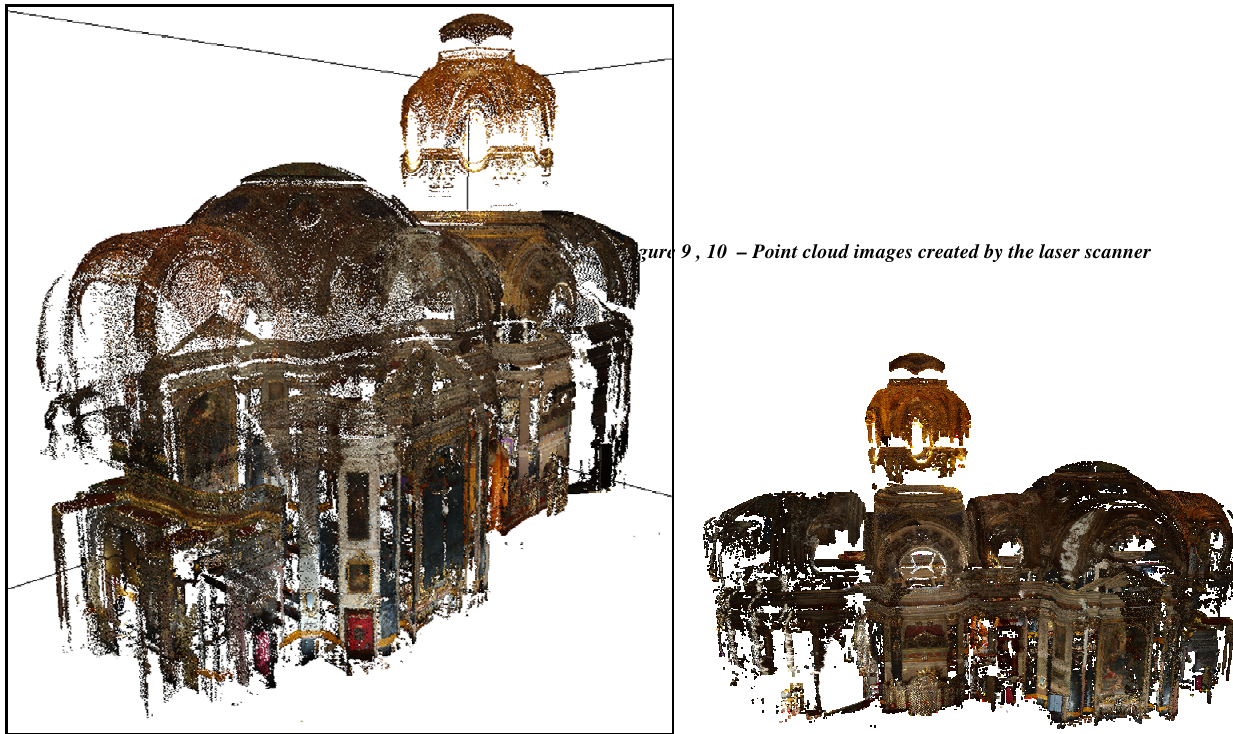
Figure 9 , 10 – Point cloud images created by the laser